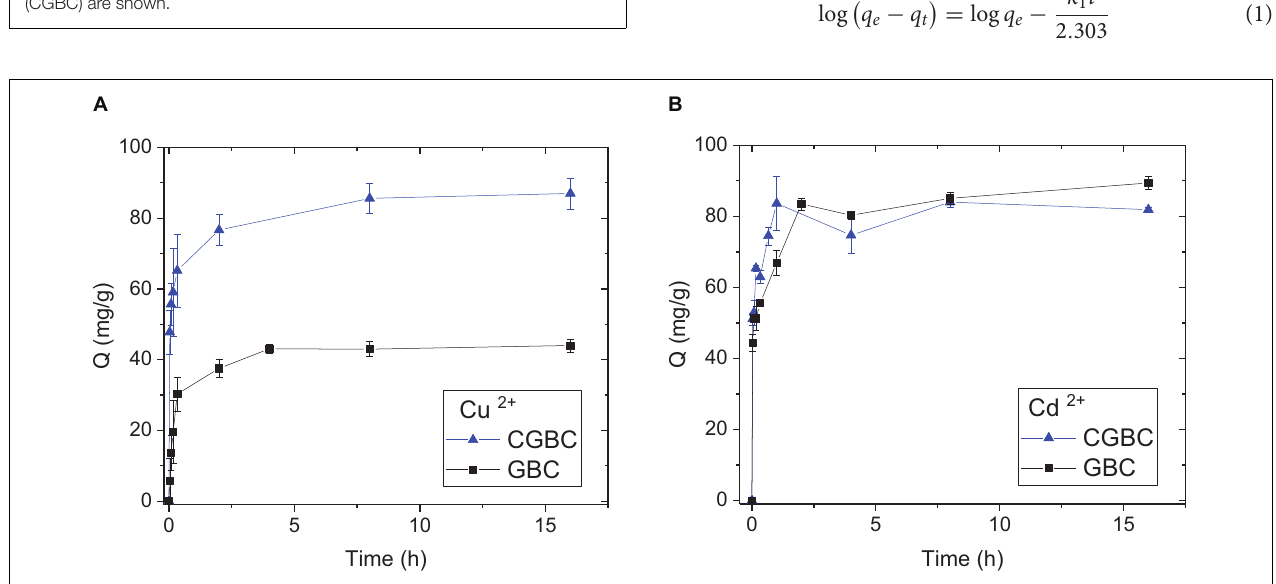
FIGURE 4 | Effect of contact time of (A) Cu 2 + and (B) Cd 2 + adsorption onto GBC and CGBC. Standard deviation error bars are from three